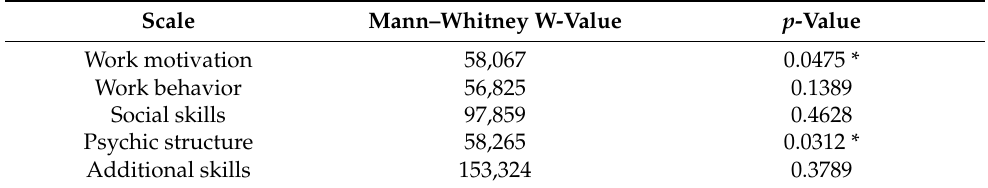
Table 21. Mann–Whitney test statistics when the sample is differentiated by tenure of the university. Scale Mann–Whitney W-Value p -Value Work motivation 58,067 0.0475 * Work behavior 56,825